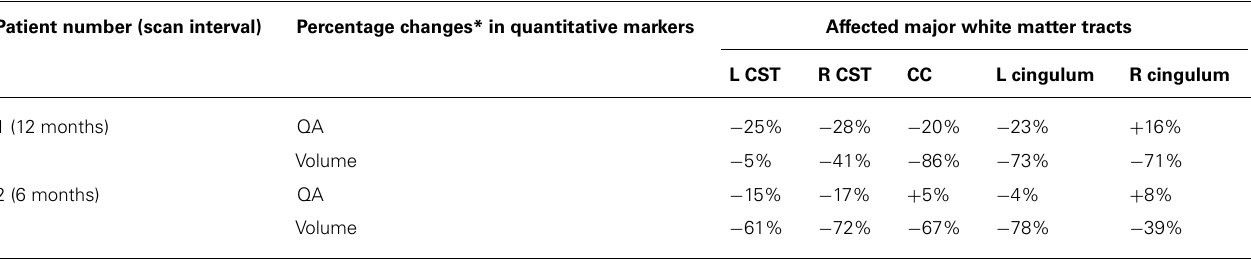
Table 1 | Changes in quantitative markers in two patients with longitudinal scans for major affected white matter tracts, as identified by the connectometry analysis. Patient number (scan